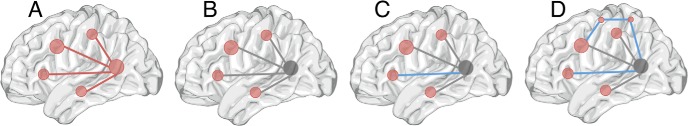
This diagram exemplifies the features evaluated by each modality. Considering a network of cortical structures (A), if one of the cortical regions is lesioned after a stroke, its connections are also affected (B; shaded gray node and gray lines). If all connections had a similar importance toward behavior (aphasia), CLSM would not distinguish between them. However, CLSM can identify which connections are more important (C; blue line). As such, CLSM is a subset of cortical lesion mapping. CDLSM, in turn, provides information about the direct and indirect connections that may be crucial for behavior (D; blue lines).